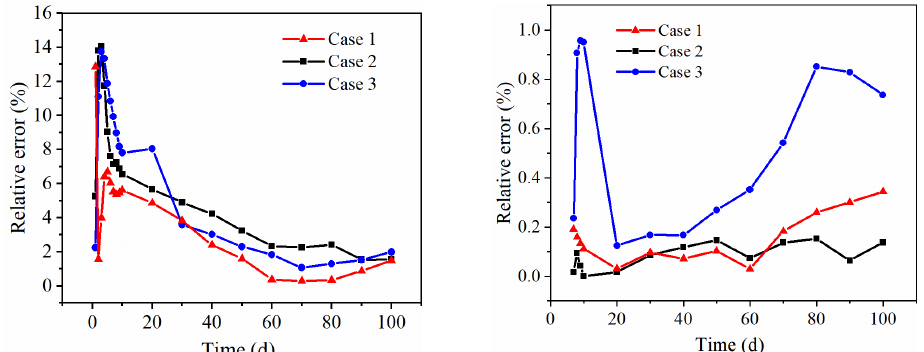
Figure 9. Relative error between the values predicted by the MLP networks (left) and LSTM networks (right) and true values under early production time.